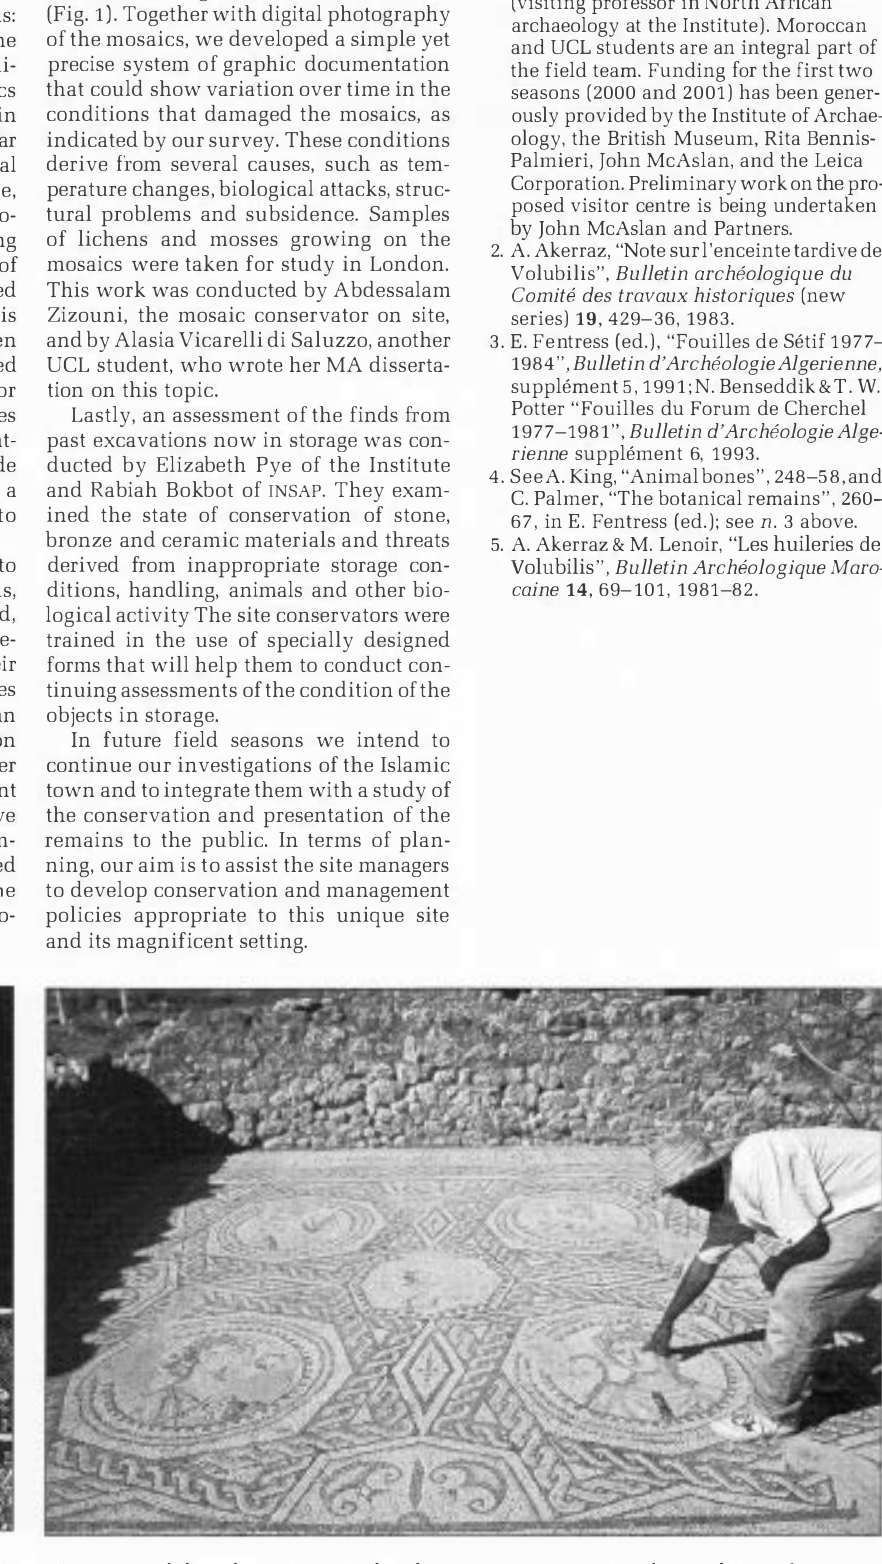
Figure 7 A tourist standing on part of a Figure 8 Abdessalam Zizouni, a local conservator, assessing the condition of a Roman ruined olive press at Volubilis. mosaic at Volubilis.